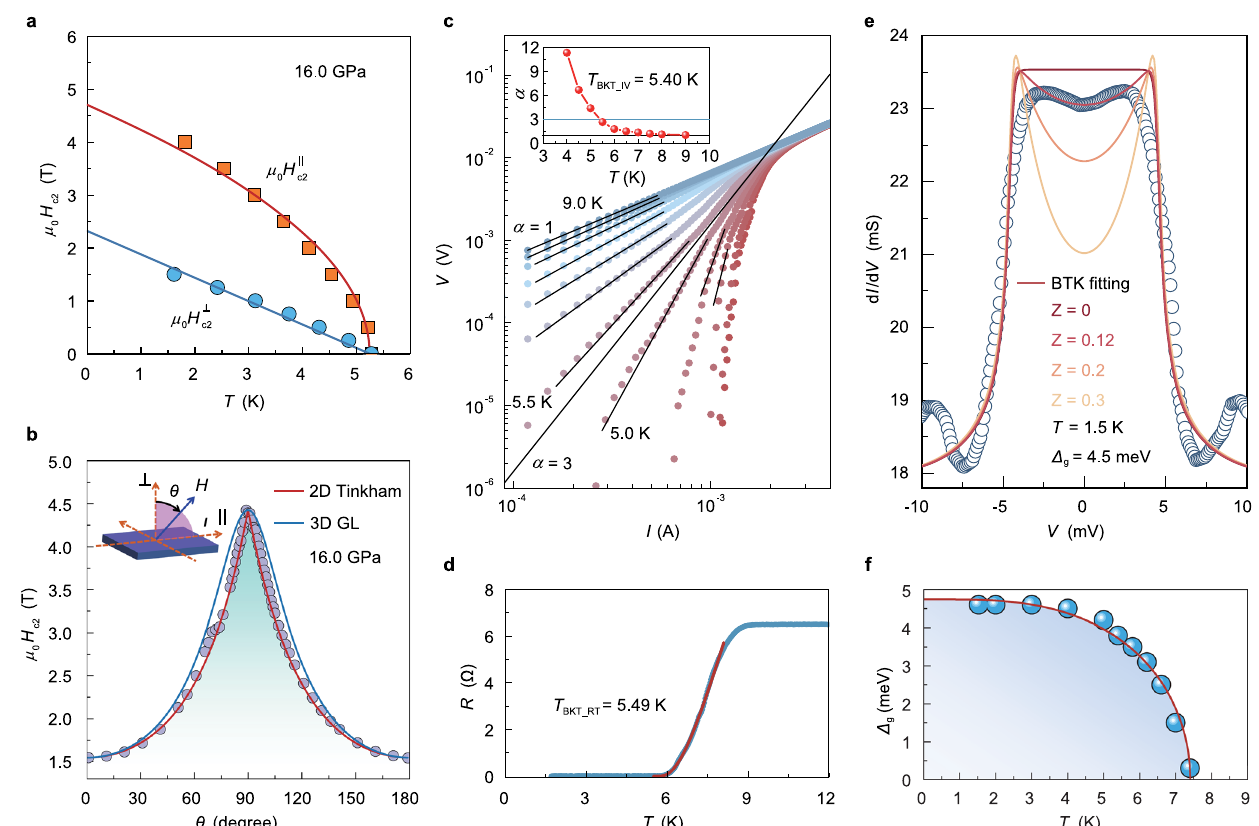
Fig. 4 | Quasi-2D superconductivity and Andreev re fl ection in pressurized GeP thin fl akes.a Temperaturedependenceof H k c2 (red squares) and H ? c2 (blue circles) at16.0GPainaGePthin fl ake(sample3).Solidlinesarethe fi tted H ? c2 T ð Þ and H k c2 T ð Þ curves based on Eq. (1) and Eq. (2), indicating quasi - 2D superconductivity therein. b Angular dependence of H c2 θ ð Þ in sample 3 at 1.5K and 16.0GPa. The inset sche-